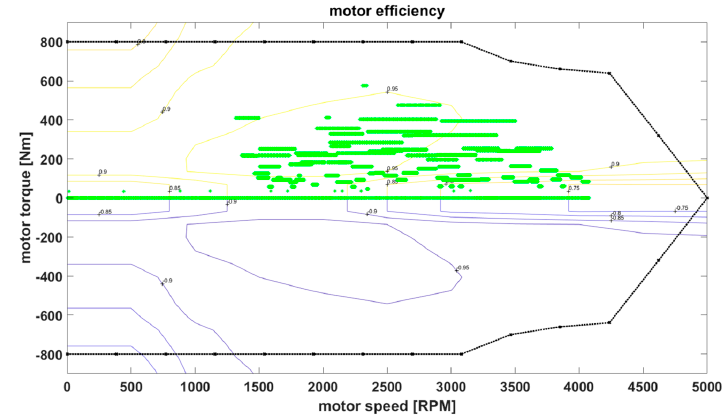
Figure 9. Electric motor operating points of HEHV (rule-based).